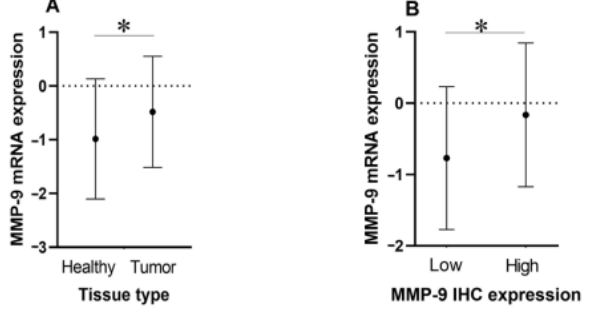
Figure 2. Comparison of relative MMP-9 mRNA levels between PTC and adjacent conditionally healthy tissue ( A ) and low and high MMP-9 protein expression groups in PTC ( B ). * p < 0.05.